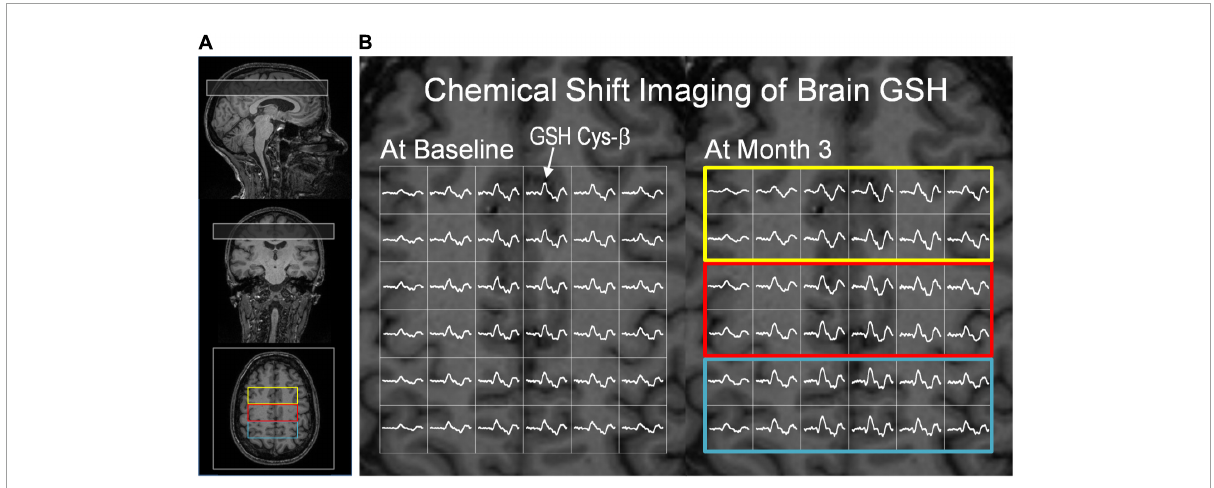
FIGURE3 Glutathione CSI and creatine CSI data from a subject in the intervention group. (A) The position of the GSH CSI slab overlaid on T1-weighted MR images. The CSI slab indicated in a rectangle was placed superior to the corpus callosum in the fronto-parietal region of the brain. (B) Partial views of brain GSH CSI of a subject in the intervention group measured at baseline (left) and after the 3-month dietary intervention (right). Brain GSH CSI is overlaid on transverse T1-weighed MRI corresponding to the middle slice of the GSH CSI slab. Regions of interest are marked by colored rectangular boxes: (yellow: frontal; red: fronto-parietal; blue: parietal). The GSH signal from cysteinyl moiety at ∼ 3 ppm was marked by an arrow. Clear spectral patterns of GSH signals across the CSI slab indicate robustness and consistency of GSH measurements at baseline and post-intervention. The GSH spectra are shown in the chemical shift range of 2.6 – 3.4 ppm.